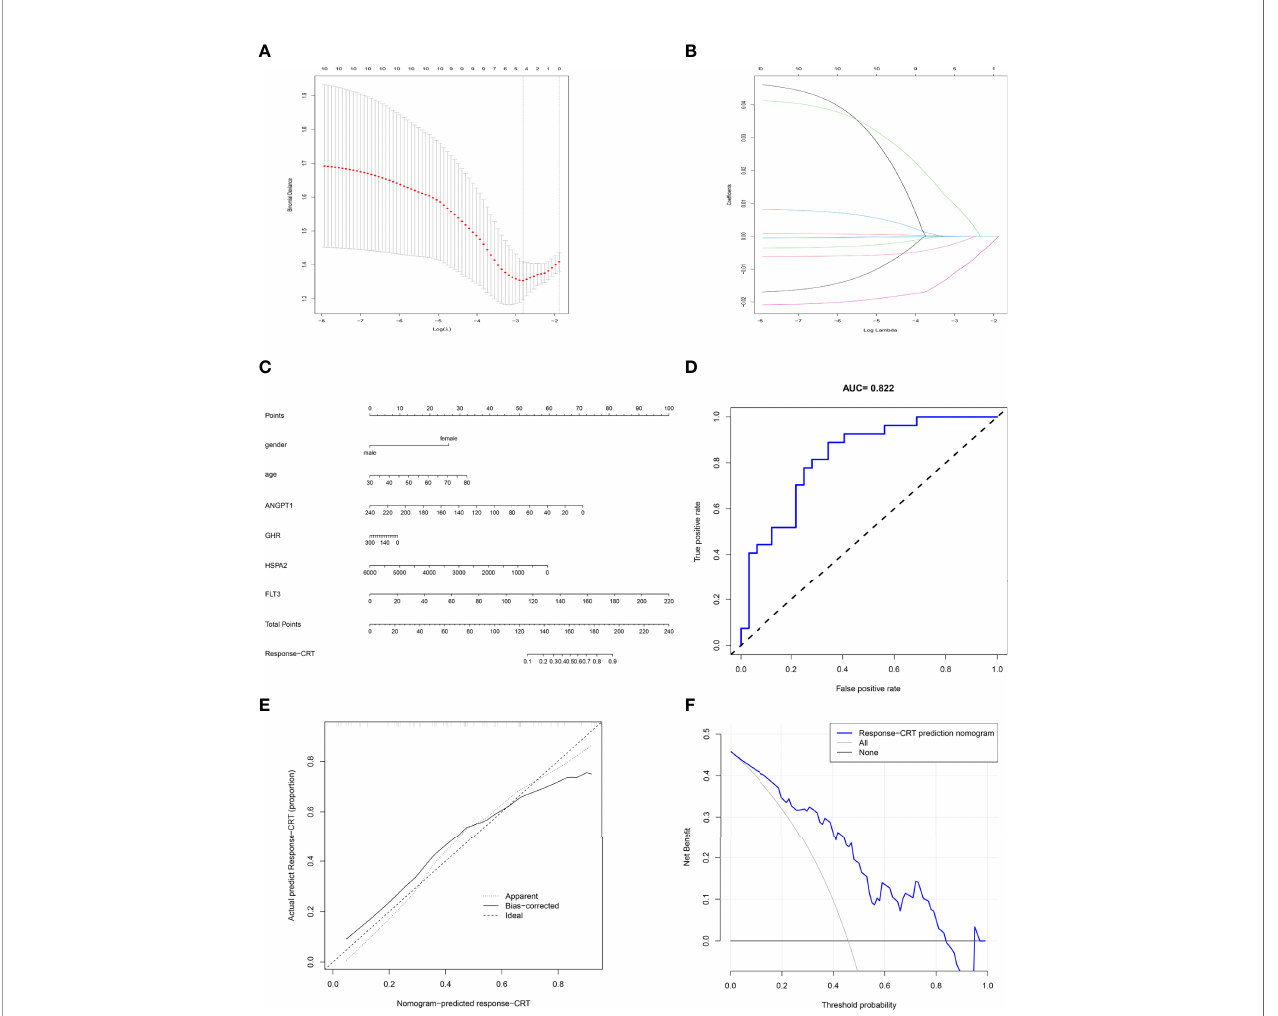
FIGURE 9 | Prediction nomogram. (A, B) LASSO regression analysis of hub immune-related DEGs. (C) Prediction nomogram for the response to CRT in LARC patients. (D) ROC curve of the nomogram. (E) Calibration curve of the nomogram. The x-axis represents the predicted response-CRT risk. The y-axis represents the actual response to CRT. The solid line represents the performance of the nomogram, a closer fi t to diagonal dotted line represents a better prediction. (F) DCA curve of the nomogram. The y-axis measures the net bene fi t. The blue line represents response-CRT nomogram. The gray line represents the assumption that all patients are responsive to CRT. The black line represents the assumption that no patients are responsive to